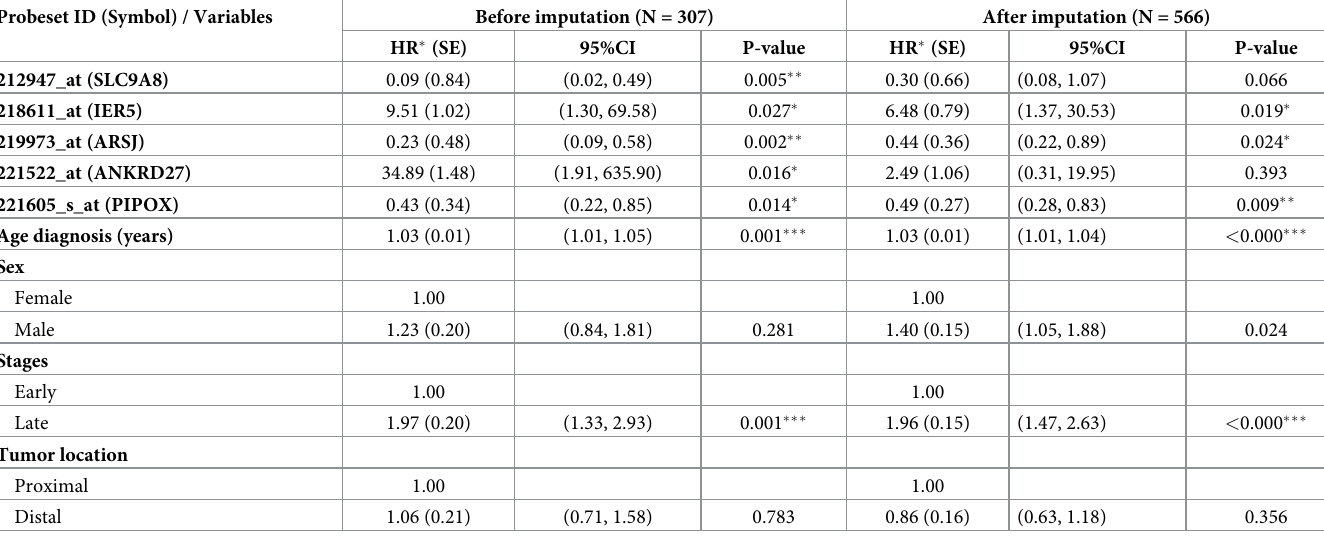
Table 4. Multivariable Cox PH results for predictors of colorectal cancer survival among adults aged 24 years and above. Probeset ID (Symbol) /